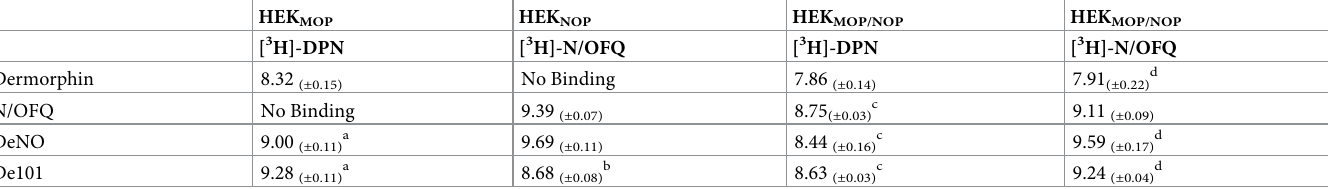
Table 2. The pK i values for Dermorphin, N/OFQ, DeNO and De101 in HEK MOP , HEK NOP and HEK MOP/NOP